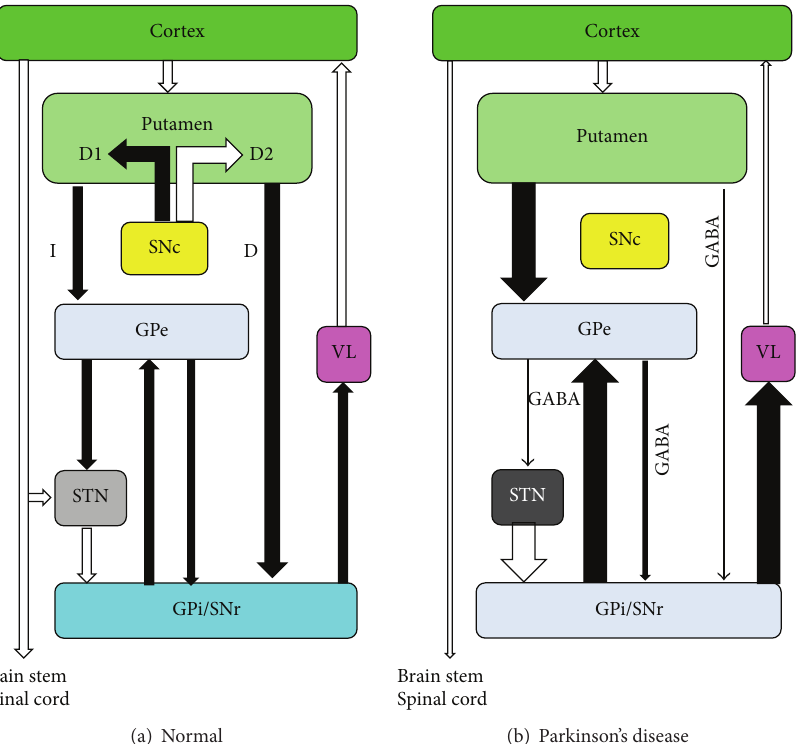
Figure 2: Schematic representation of the activity of the cortical-basal ganglia circuits in normal subjects (a) and in patients with Parkinson’s disease/Parkinsonism (b), resulting in a possible compensatory upregulation of GABA A receptors in various nuclei (STN, GPi, and SNr), which are overactive in PD. In PD, the underactivity of GABAergic neurons of the putamen and caudate projecting to GPi and SNr through the direct (D) pathway (b) may result in compensatory upregulation of GABA A receptors [39] in deafferented brain structures, namely, the GPi and SNr (b). Similarly, we can hypothesize that in PD the decreased GABAergic inhibition exerted by the external globus pallidus (GPe) through the indirect (I) pathway on the glutamatergic neurons of the STN and the GABAergic neurons of the GPi and SNr (b) may result in compensatory upregulation of GABA A receptors in such deafferented brain structures (STN, GPi, and SNr). Such compensatory upregulation of GABA A receptors in deafferented brain structures (STN, GPi, and SNr) could be more marked in PD patients who, after the administration of zolpidem, show more evident beneficial effects on Parkinsonian motor symptoms and show no or minimal drowsiness. White arrows = excitatory connections; black arrows = inhibitory